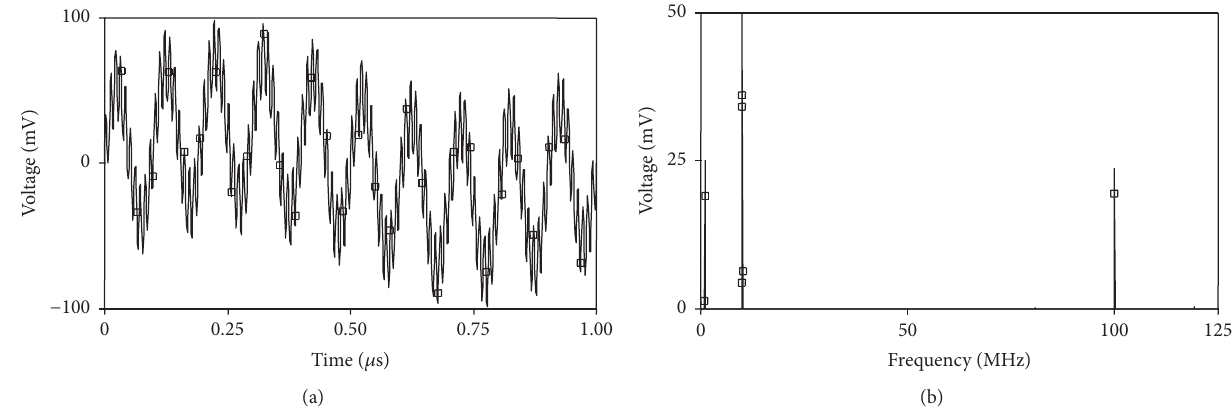
Figure 10: (a) The voltage input transient signal and (b) its frequency spectrum.